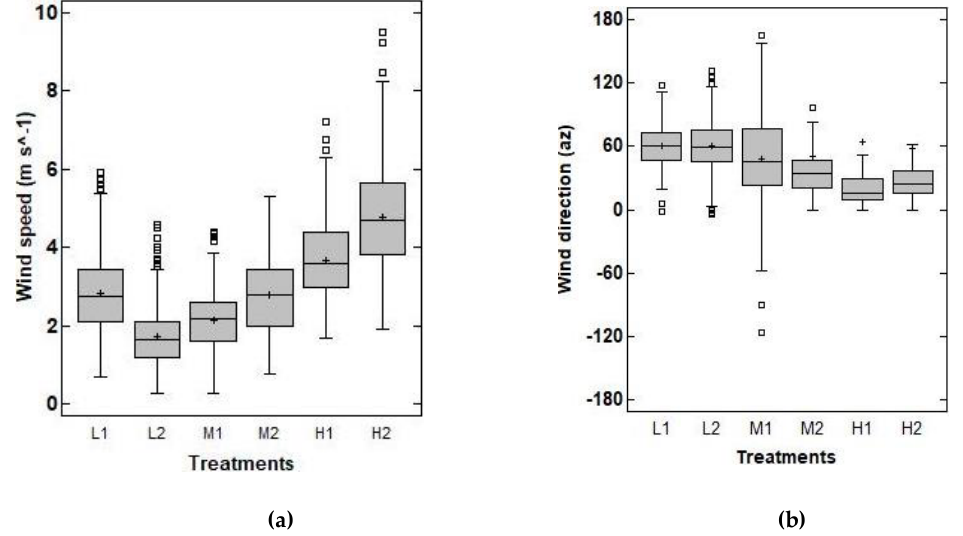
Figure 4. Boxplots of all wind speed and wind direction measurements; ( a ) wind speed; ( b ) wind direction.